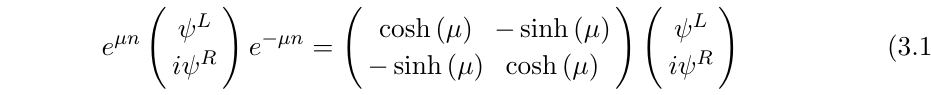
Figure 3 . Schematic illustration of the size distribution P n (black curve) which naturally decomposes into a convolution of a growth distribution K (cid:12) (blue dashed curve) with the size distribution P n This is due to the factorization relation of their respective generating functions